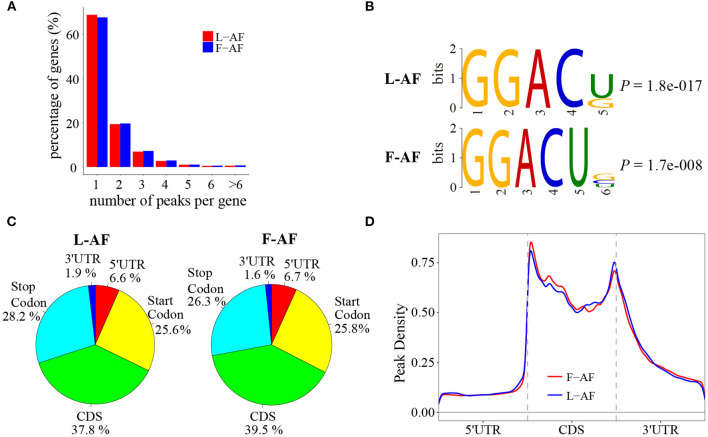
Overview of N6-methyladenosine methylation within mRNAs in fat- and lean-line broiler chickens. (A) Sequence motif of m6A-containing peak regions. (B) Percentage of m6A-methylated transcripts with different number of m6A peaks. (C) Pie charts showing the percentage of m6A peaks in five non-overlapping segments of mRNA transcripts. (D) Enrichment of m6A peaks along mRNA transcripts. L-AF and F-AF represent abdominal fat tissue from lean- and fat-line chickens, respectively.